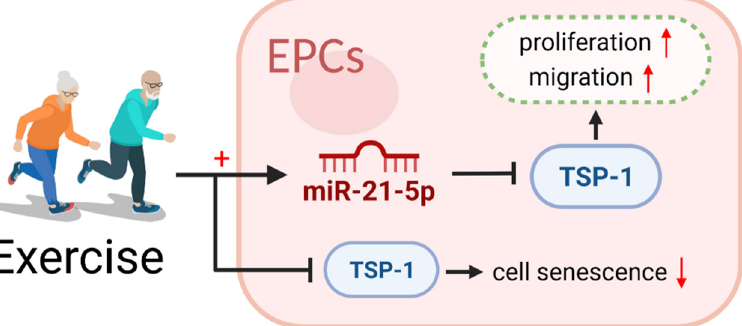
Figure 5. Long ‐ term aerobic exercise improves the proliferation and migration functions of EPCs in aging individuals by upregulating miR ‐ 21 ‐ 5p expression and inhibiting TSP ‐ 1 expression. It reduces the senescence rate of EPCs by downregulating TSP ‐ 1 expression. miR ‐ 21 ‐ 5p is a key regulator of the proliferation and migration functions of EPCs via TSP ‐ 1 expression.